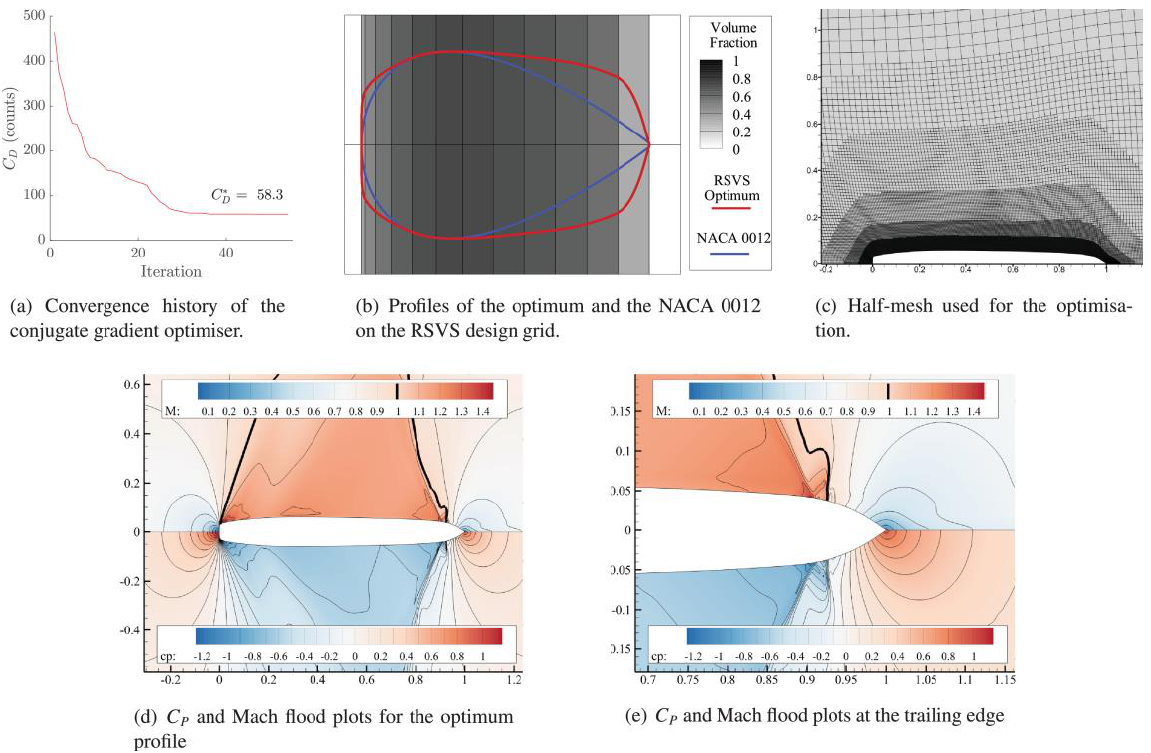
Figure 2. Optimization of the ADODG Case one using ten active design variables